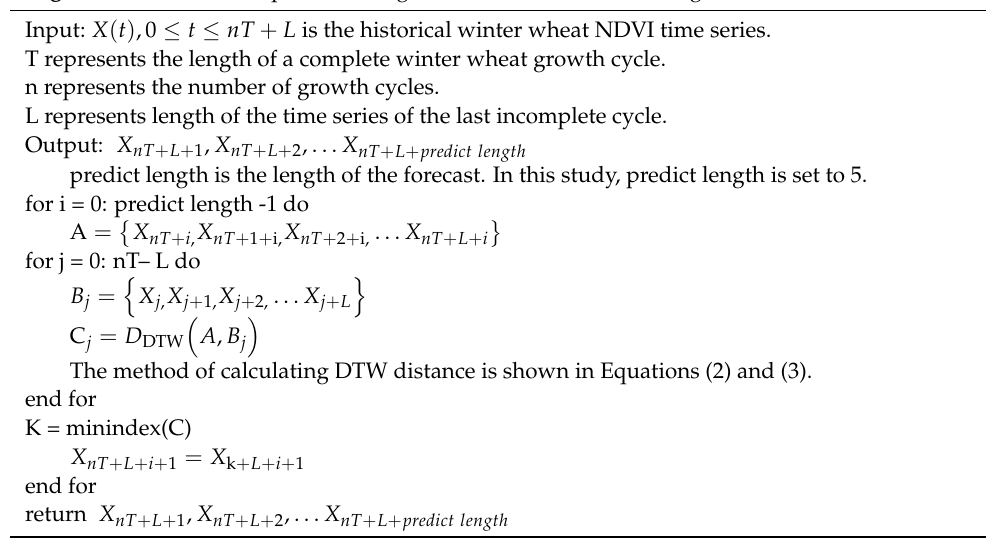
Figure 3. Schematic diagram of time series prediction using the DTW algorithm. Algorithm 1 can be used to express the entire process: Algorithm 1 Time series prediction algorithm based on the DTW algorithm